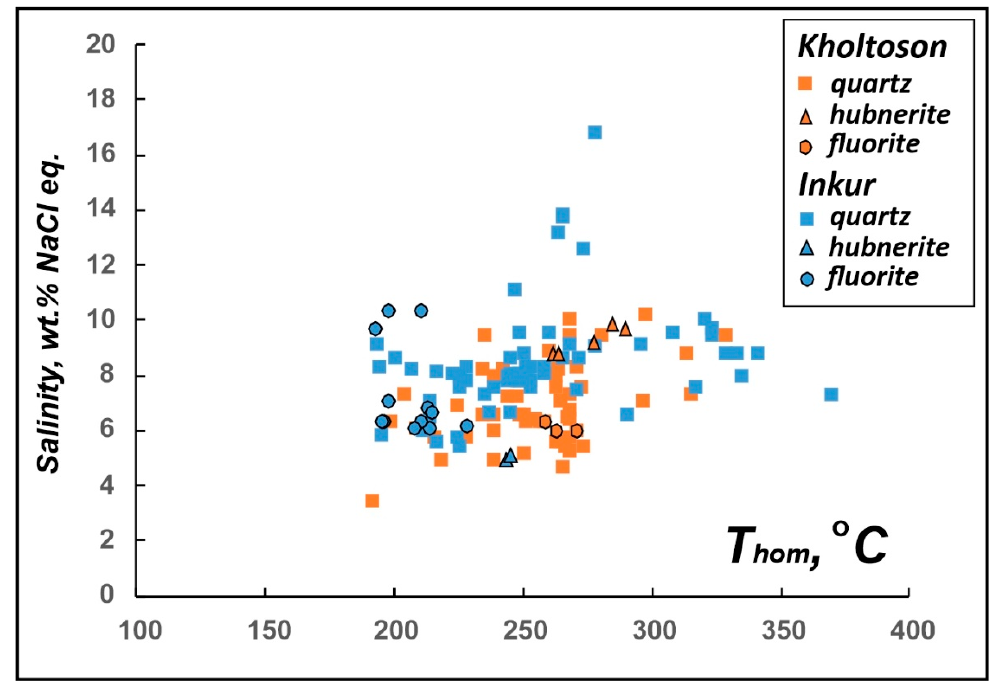
Figure 8. Binary salinity-homogenization temperature diagram for FIs from the Inkur and Kholtoson deposits.